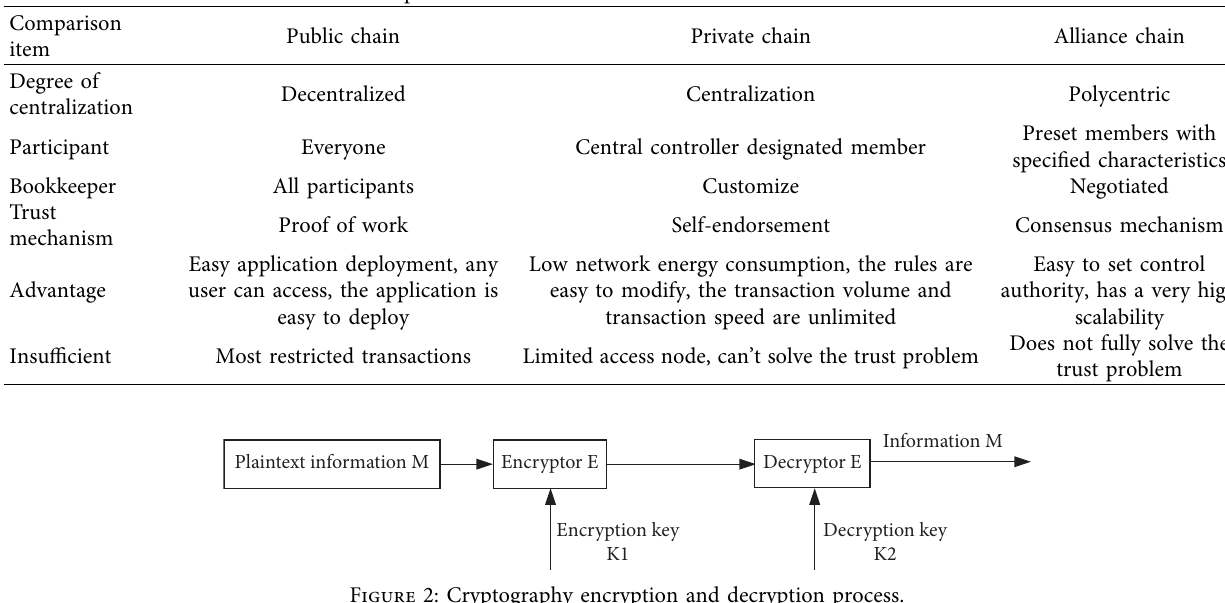
Table 1: Comparison of the characteristics of the three forms of